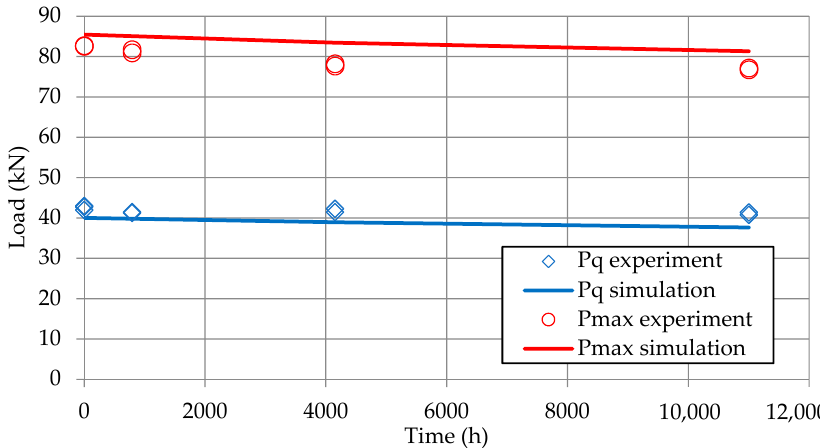
Figure 10. Numerically and experimentally determined P Q and P max loads of steel P91 at different ageing times.